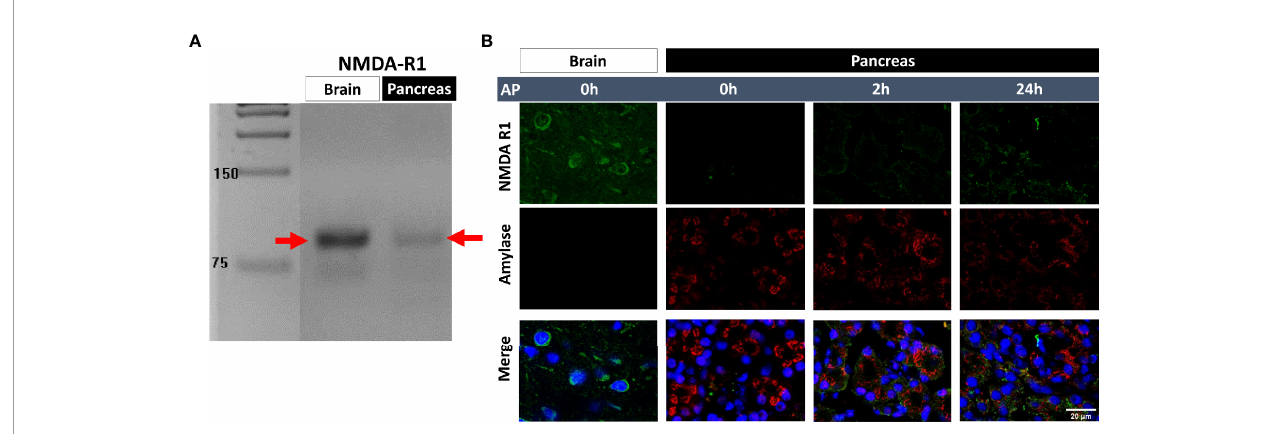
FIGURE 7 | Detection of N-methyl-D-aspartate receptor 1 (NMDAR1) expression. (A) NMDAR1 mRNA expression in brain cortex and pancreas, (B) representative immuno fl uorescent images (NMDAR1, amylase, and cellular nuclei stainings) of pancreatic tissue (scale bar: 20 µm). Panc,